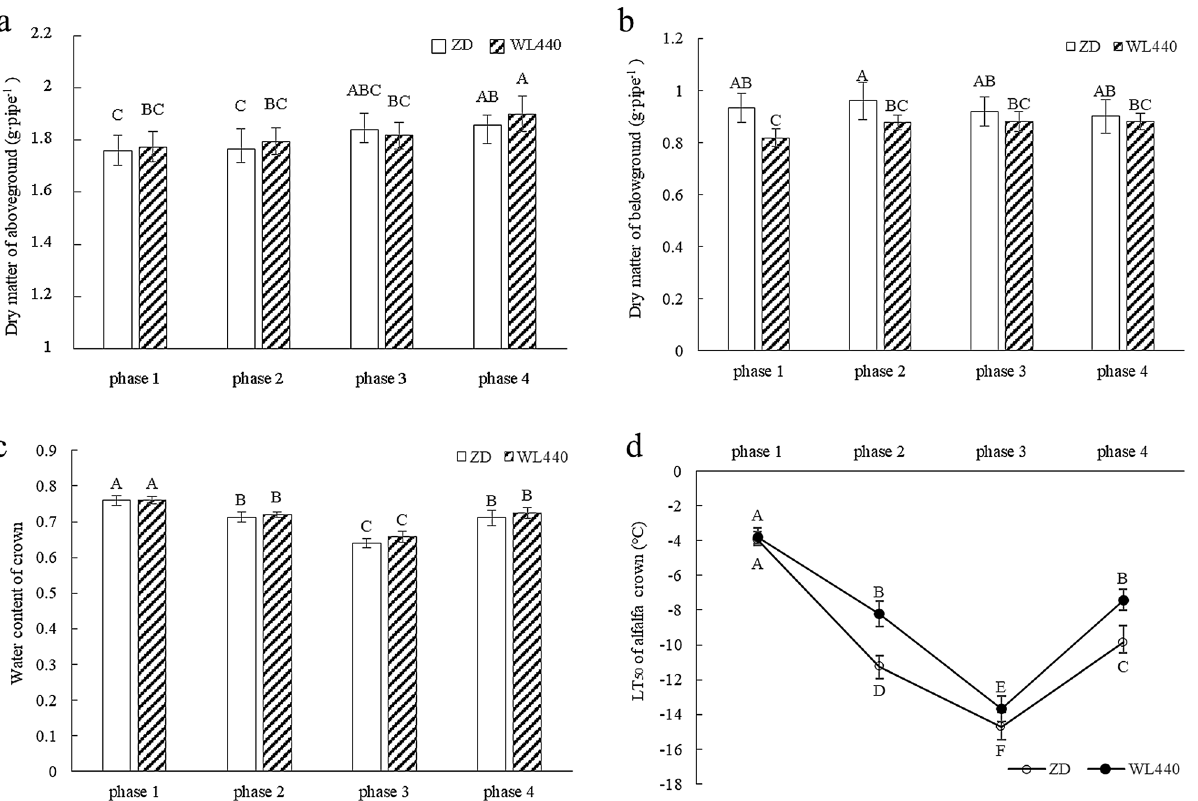
Figure 2. Changes of dry matter of aboveground ( a ) and belowground ( b ), water content ( c ) and semi-lethal temperature ( d ) of crown in four phases. Different capital letters represent significant differences between samples at 0.01